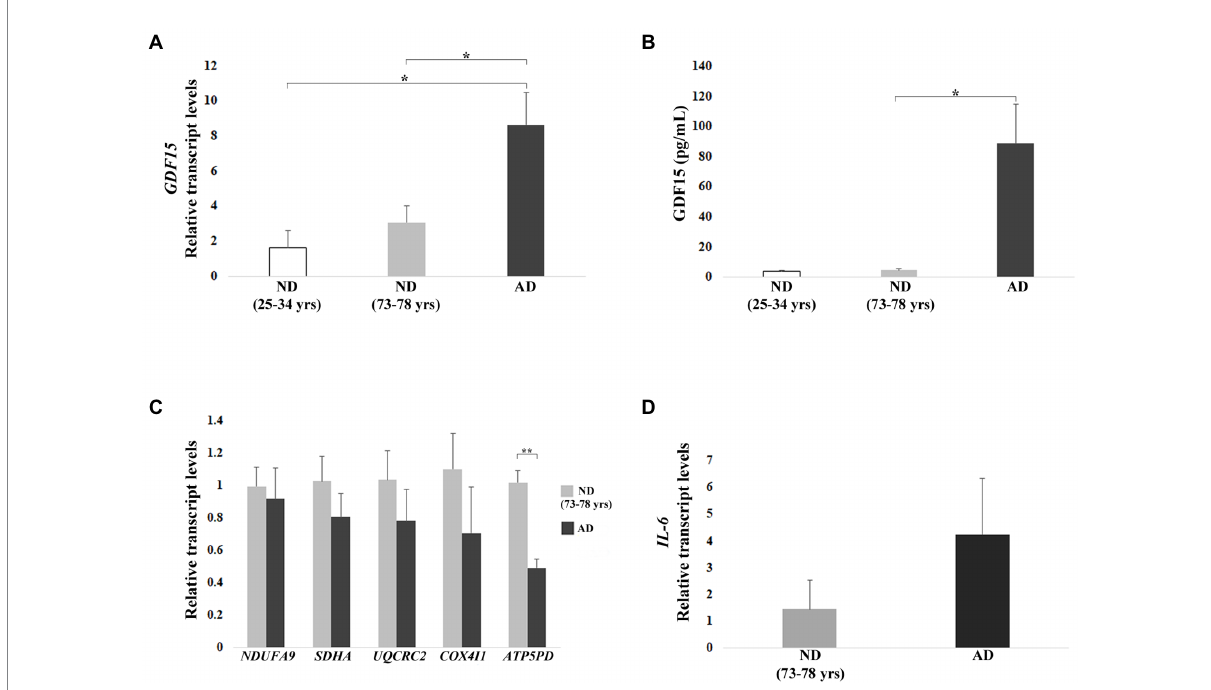
FIGURE 6 Real-time RT-PCR analyses and ELISA in dermal fibroblasts (DFs) from three non-demented young subjects (ND, age range 25–34 years), 8 non- demented old subjects (ND, age range 73–78 years), and 3 AD patients (AD). (A) Relative GDF15 transcript level and (B) quantification by ELISA of GDF15 protein secreted in the culture medium. (C) Mitochondrial complex subunits ( NDUFA9 , SDHA , UQCRC2 , COX4I1 , ATP5PD ) and (D) IL-6 relative transcript levels. The bars represent mean ± SE. Student’s t and one-way ANOVA tests with Bonferroni correction were applied for transcript-level analyses. Kruskal–Wallis test was applied for ELISA analysis [AD vs. ND (25–34 years) p = 0.067]. * p < 0.05. ** p <